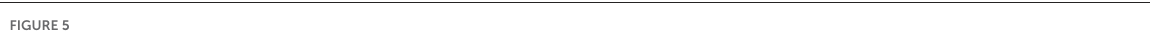
FIGURE5 ε values stated, what species they referred to and whether the values used could be traced to a measured ε value. Arrow direction indicates referencing of older articles. The first author’s name, the year of publication and the emissivity value used (if present) are included. For papers that could not be classified based on ‘species,’ the object is stated. For ease of illustration, only the original research articles and the manufacturer’s manual that were referenced are included in the diagram. This figure illustrates that most primary sources are human emissivity values and only two values have been measured in livestock, both in pigs.